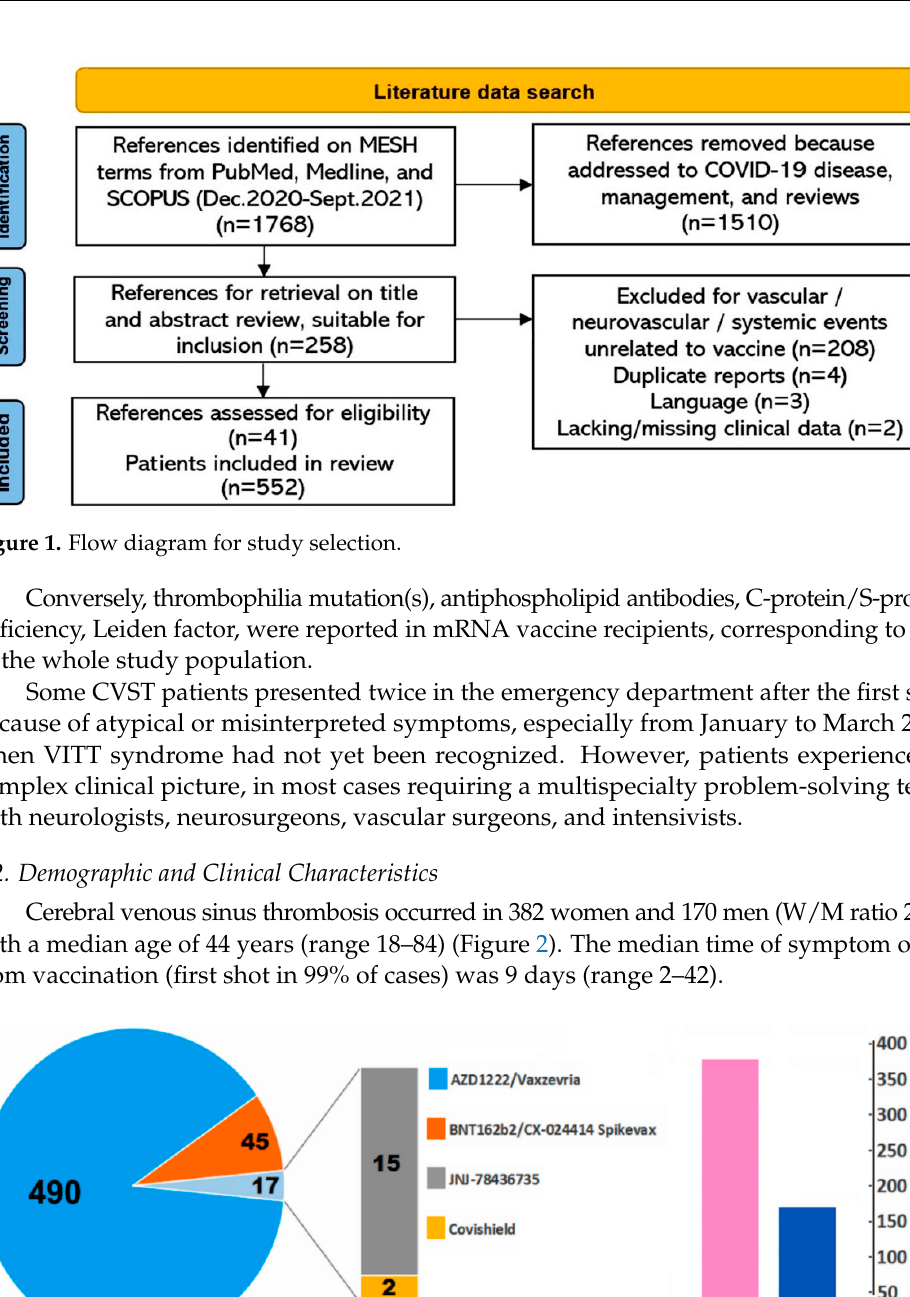
Figure 1. Flow diagram for study selection.